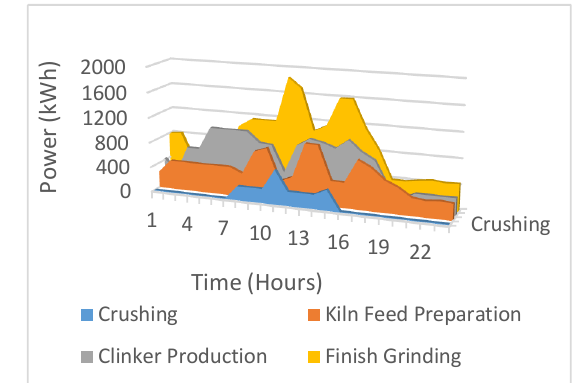
Fig. 5: Hourly Energy Demand of Element